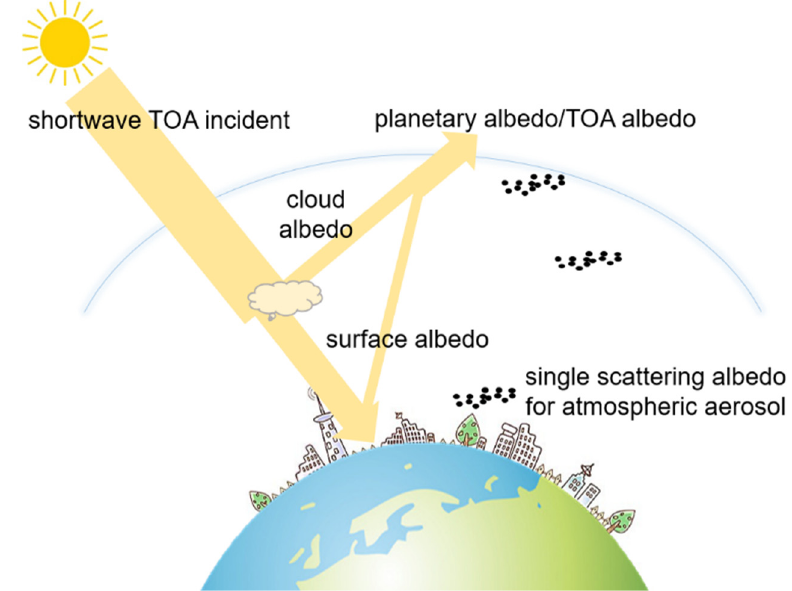
Figure 1. The scenario for several essential albedo variables.